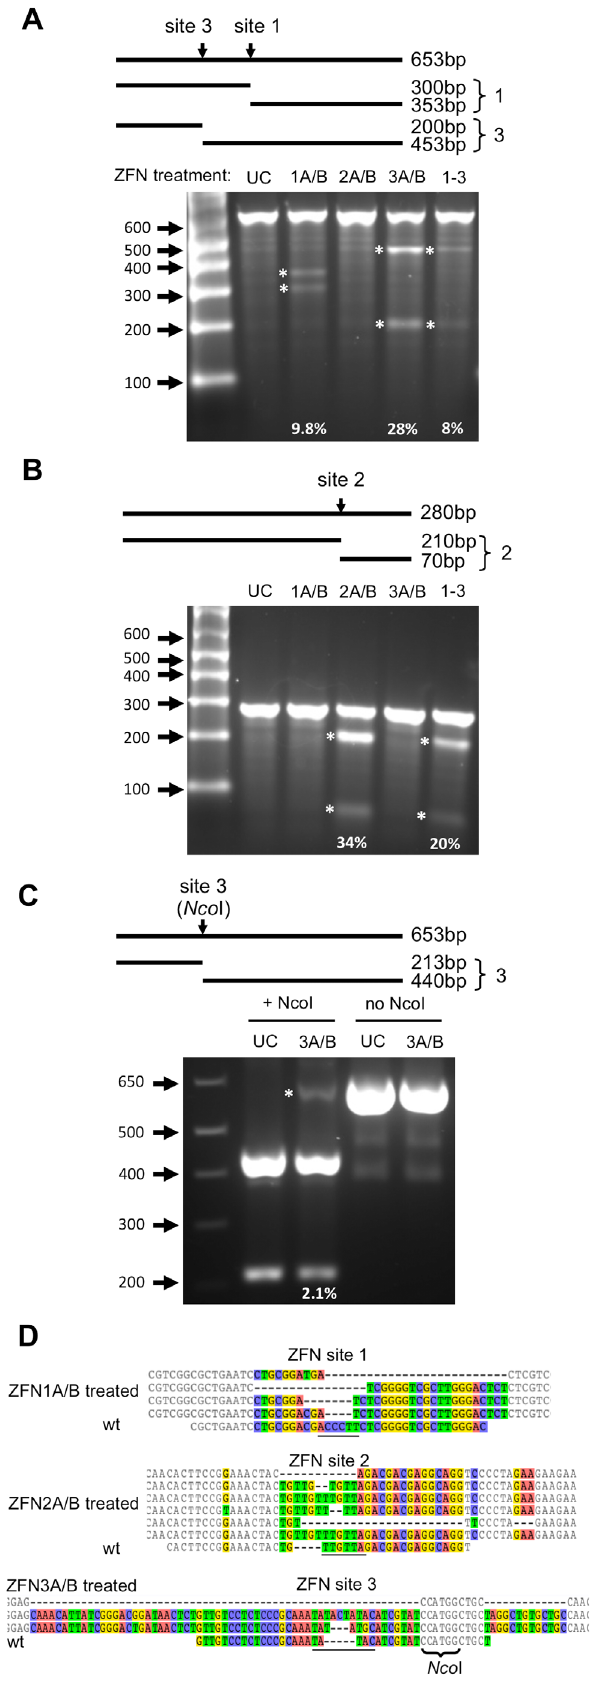
Figure 5. ZFN-induced target site disruption in HepAD38 cells. ( a,b ) Cells were transduced with scAAV2 vectors expressing ZFN pairs 1, 2, 3 or all three pairs together (1–3) at a total MOI of 10000 genomes/ cell. The presence of mutations was analyzed in DNA isolated from transduced cells 72 hours later using the Surveyor nuclease assay. ( c ) For ZFN site 3, an analysis of DNA mutagenic events disrupting the internal NcoI cleavage site was also performed. Above the gel images, the sizes of PCR amplicons and the cleavage products produced upon Surveyor nuclease cleavage (indicating mutations at the indicated target site) or NcoI cleavage are shown. bp – base pairs; UC – untreated control; ZFN – zinc finger nuclease. Bands indicating mutations are highlighted with an asterisk and the percentage of ZFN-mediated DNA mutation for each targeted site is indicated. ( d ) DNA mutations that were detected at ZFN target sites 1, 2 and 3 within HepAD38 HBV sequences are shown above the wild-type ZFN site. Nucleotides with differences in at least one sequence are shown in color. Spacer regions are underlined. The rates at which DNA mutations were detected are listed in Table 1. wt – wild